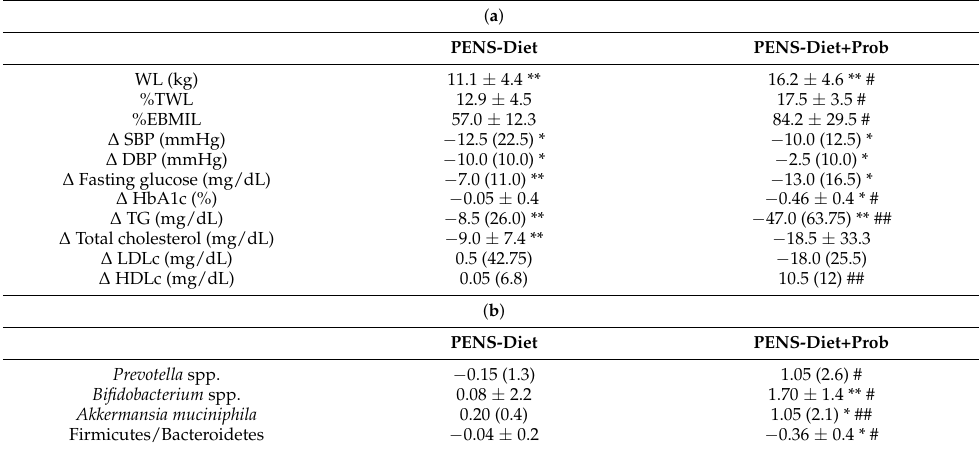
Table 1. Clinical and microbiota outcomes in obese patients after PENS-Diet and PENS-Diet+Prob